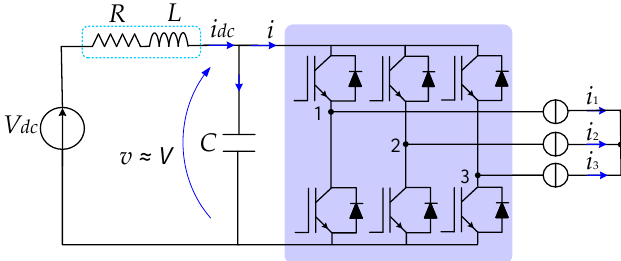
Figure 1. Circuit scheme of the three-phase voltage source inverter ( VSI) under investigation.